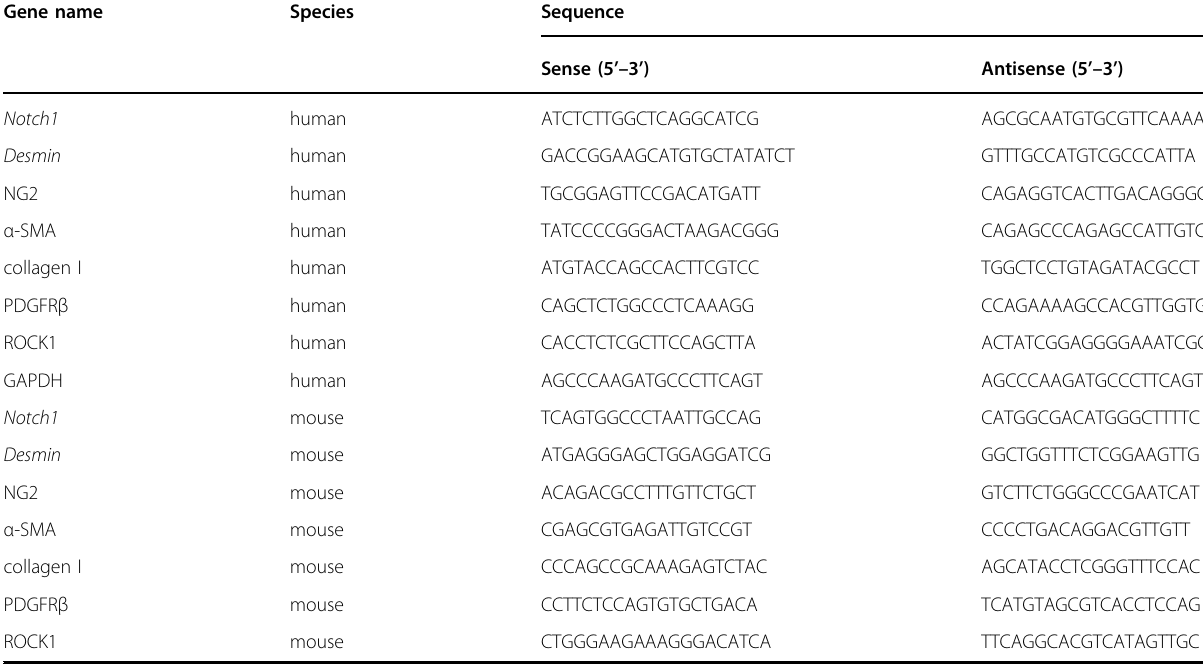
Table 1 The sequences for RT-qPCR